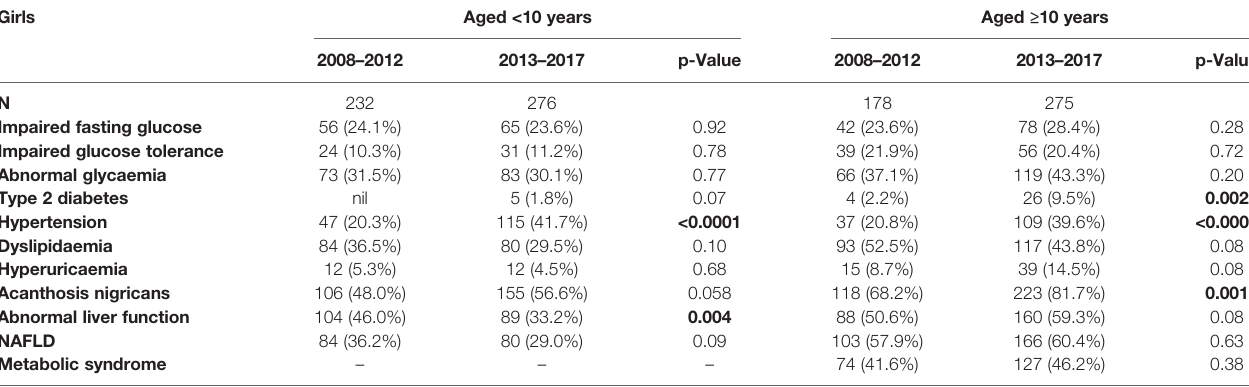
TABLE 6 | Incidence of cardiometabolic comorbidities among Chinese girls with obesity assessed between 2008 and 2017 in Hangzhou (Zhejiang Province, China).